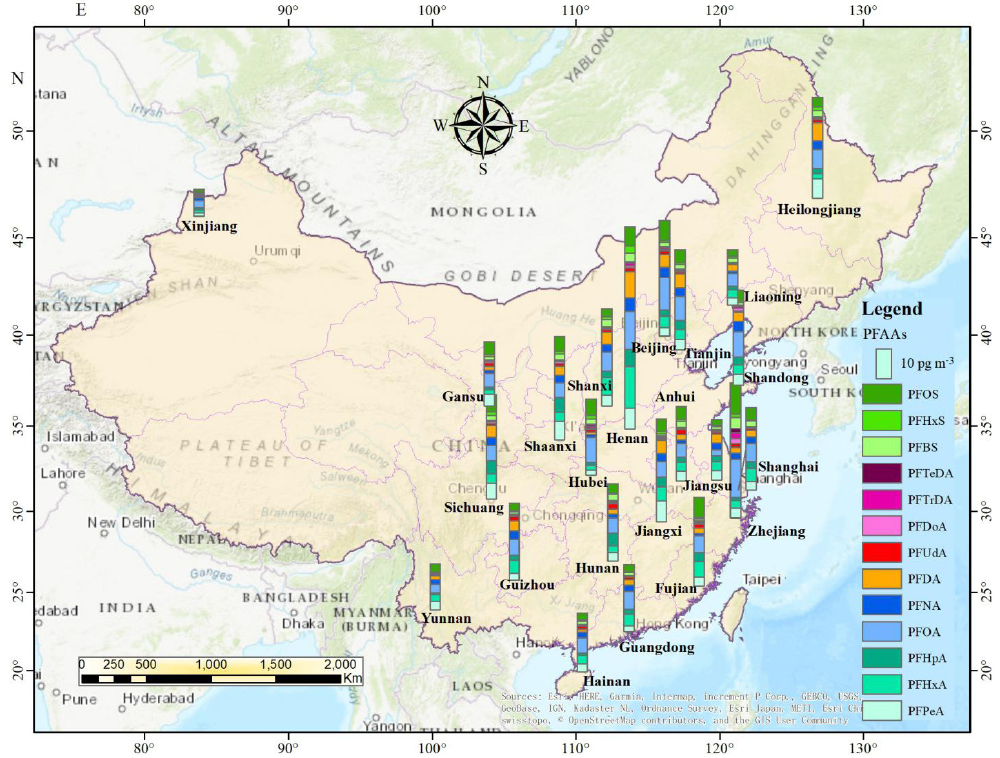
Figure 2. The spatial distributions of PFAAs in the study area (annual average of PFAAs, created by ArcGIS 10.4). © OpenStreetMap contributors 2019. Distributed under a Creative Commons BY-SA